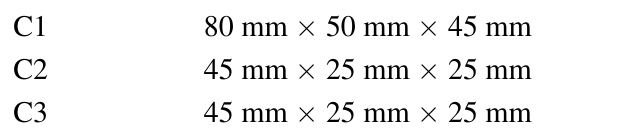
Table 2. Minimum dimension of the measurement